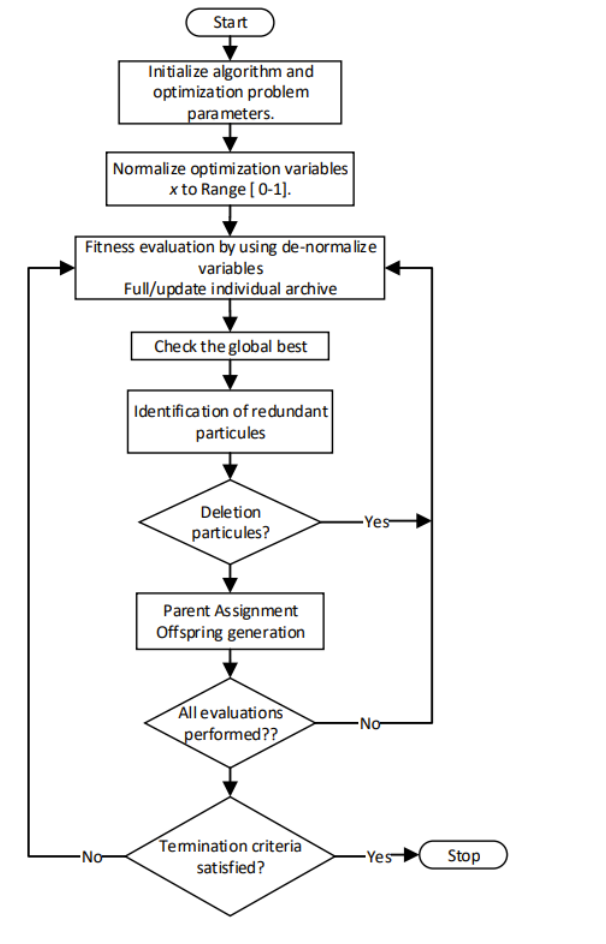
Figure 6. Flowchart of the implemented MVMO